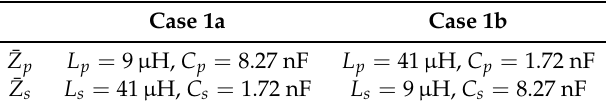
Table 5. Filter parameters for Case Study 1.